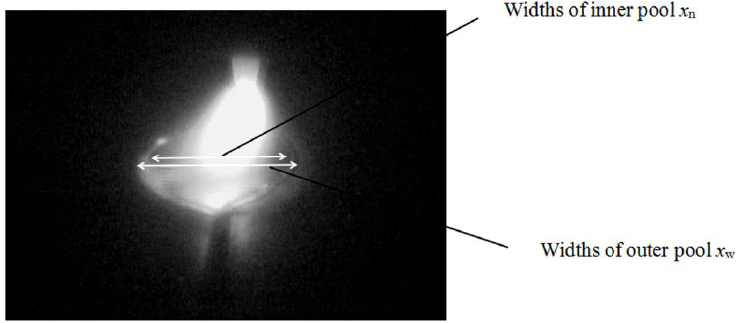
Fig. 10 Widths of inner pool and outer